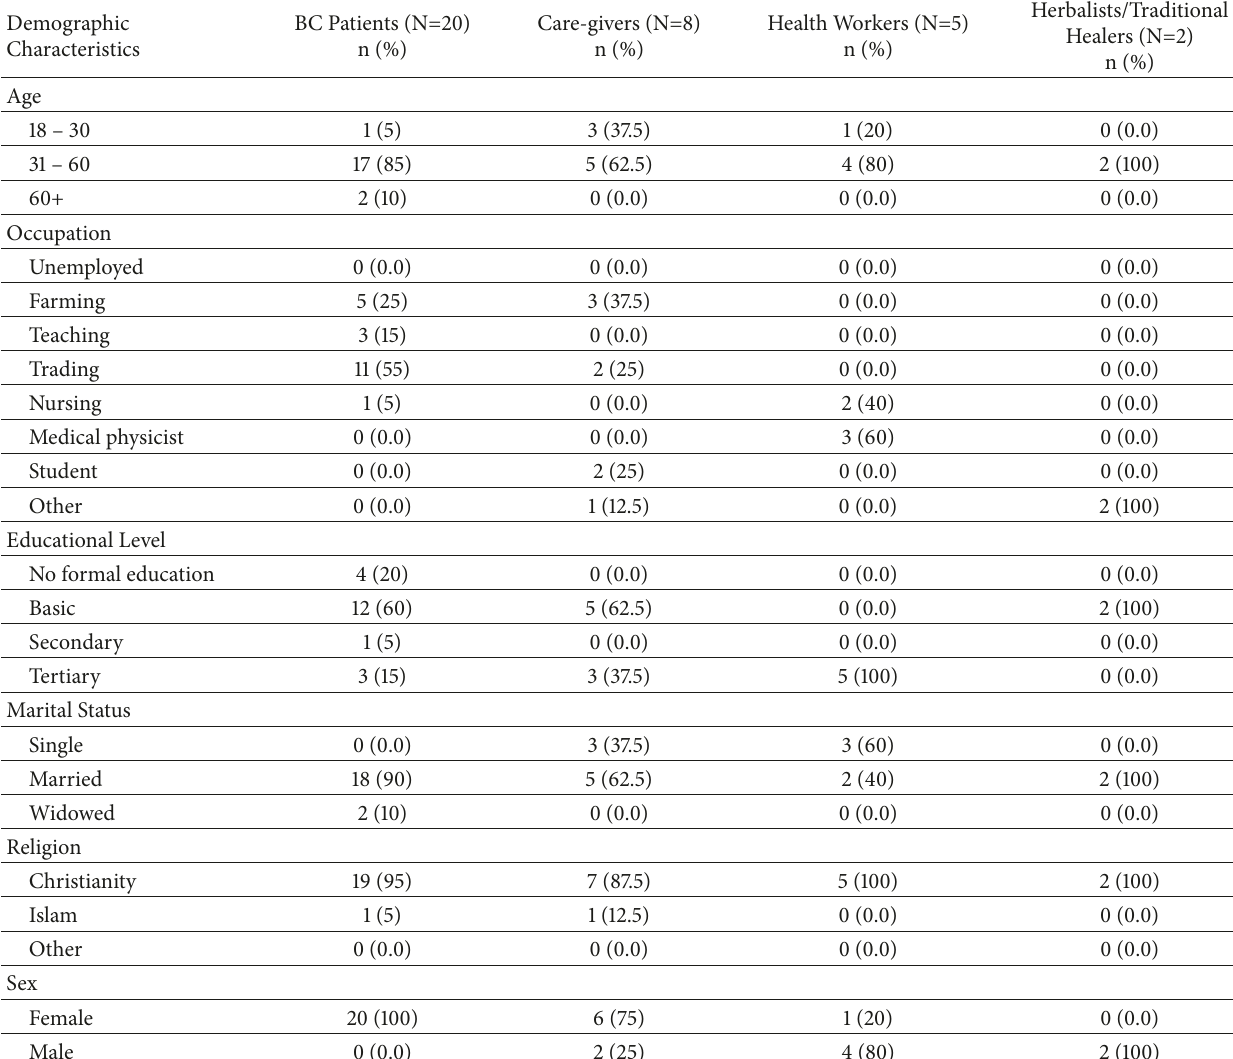
Table 2: Participants’ social and demographic profile (N =